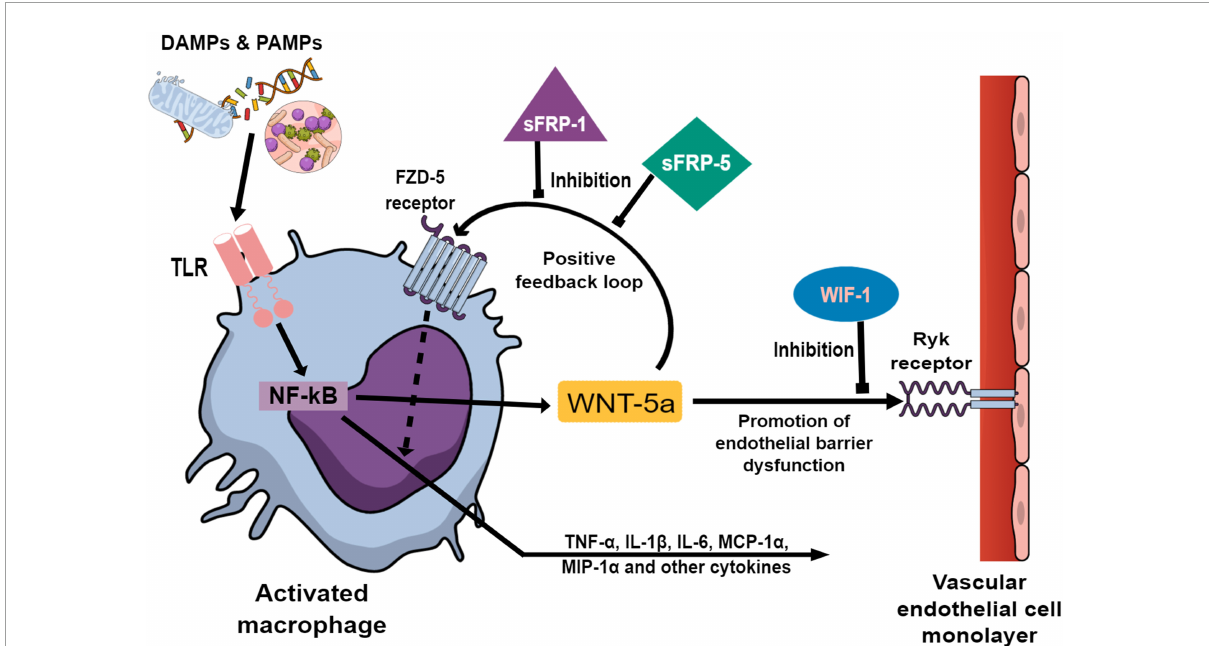
FIGURE1 Preclinical studies investigating Wingless-related integration site (WNT) signaling components (9–11, 30) are graphically summarized to elucidate the background of this translational study. Damage and pathogen associated molecular patterns (DAMPs and PAMPs) activate macrophages via Toll-like receptors (TLR) which in turn promote transcription factor NF- κ B to upregulate the expression of WNT-5a and a wide array of inflammatory cytokines. After secretion, WNT-5a binds to the membrane bound Frizzled-5 (FZD-5) receptor on the activated macrophages leading to an augmentation of the inflammatory cytokine production. This autocrine action enables WNT-5a to sustain the inflammatory response unrelated to the original stimulus. The positive feedback loop of WNT-5a is antagonized by Secreted frizzled-related protein 1 (sFRP-1) and Secreted frizzled-related protein 5 (sFRP-5) at the FZD-5 receptor. In vascular endothelial cells (VEC), WNT-5a promotes the loosening of intercellular tight junctions leading to increased paracellular permeability. This paracrine effect of WNT-5a is antagonized by WNT inhibitory factor 1 (WIF-1) at the membrane bound Ryk-receptor on